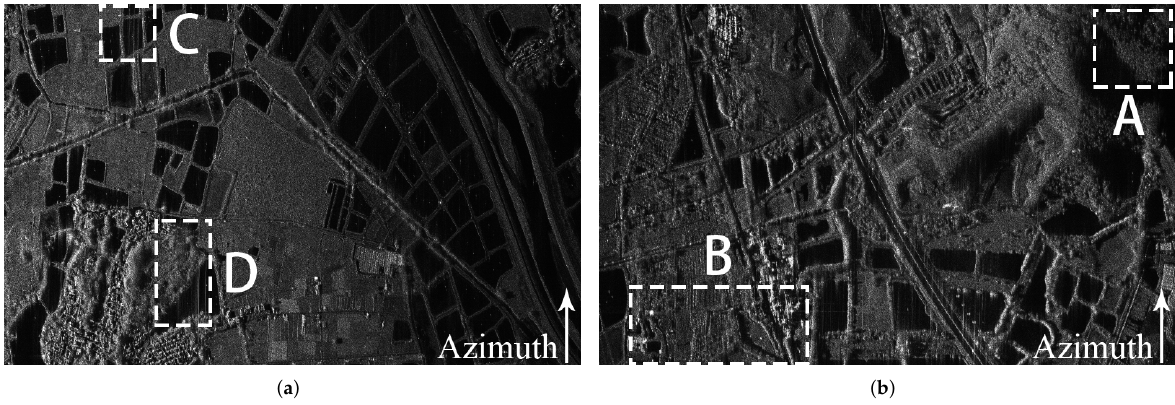
Figure 22. The images of the proposed scheme. ( a ) The near-end sub-swath. ( b ) The far-end